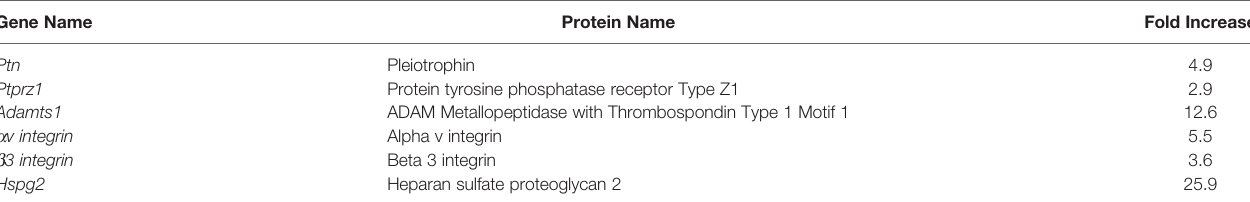
TABLE 1 | Fold increase in selected genes related to PTN presence or action in Ins + Glut2 LO cells relative to Ins + Glut2 HI cells isolated from pancreata of young mice (postnatal day